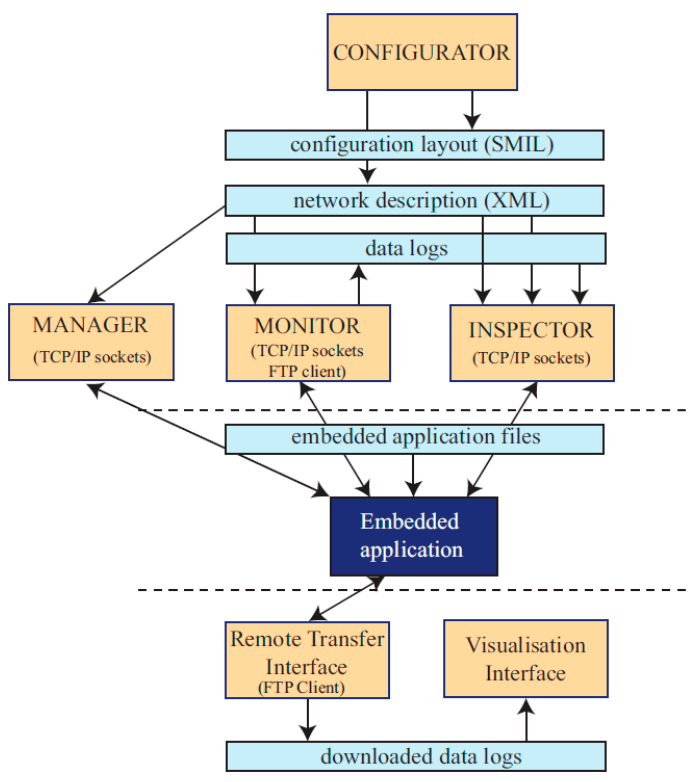
Figure 18. Files generated and exchanged by applications [16].